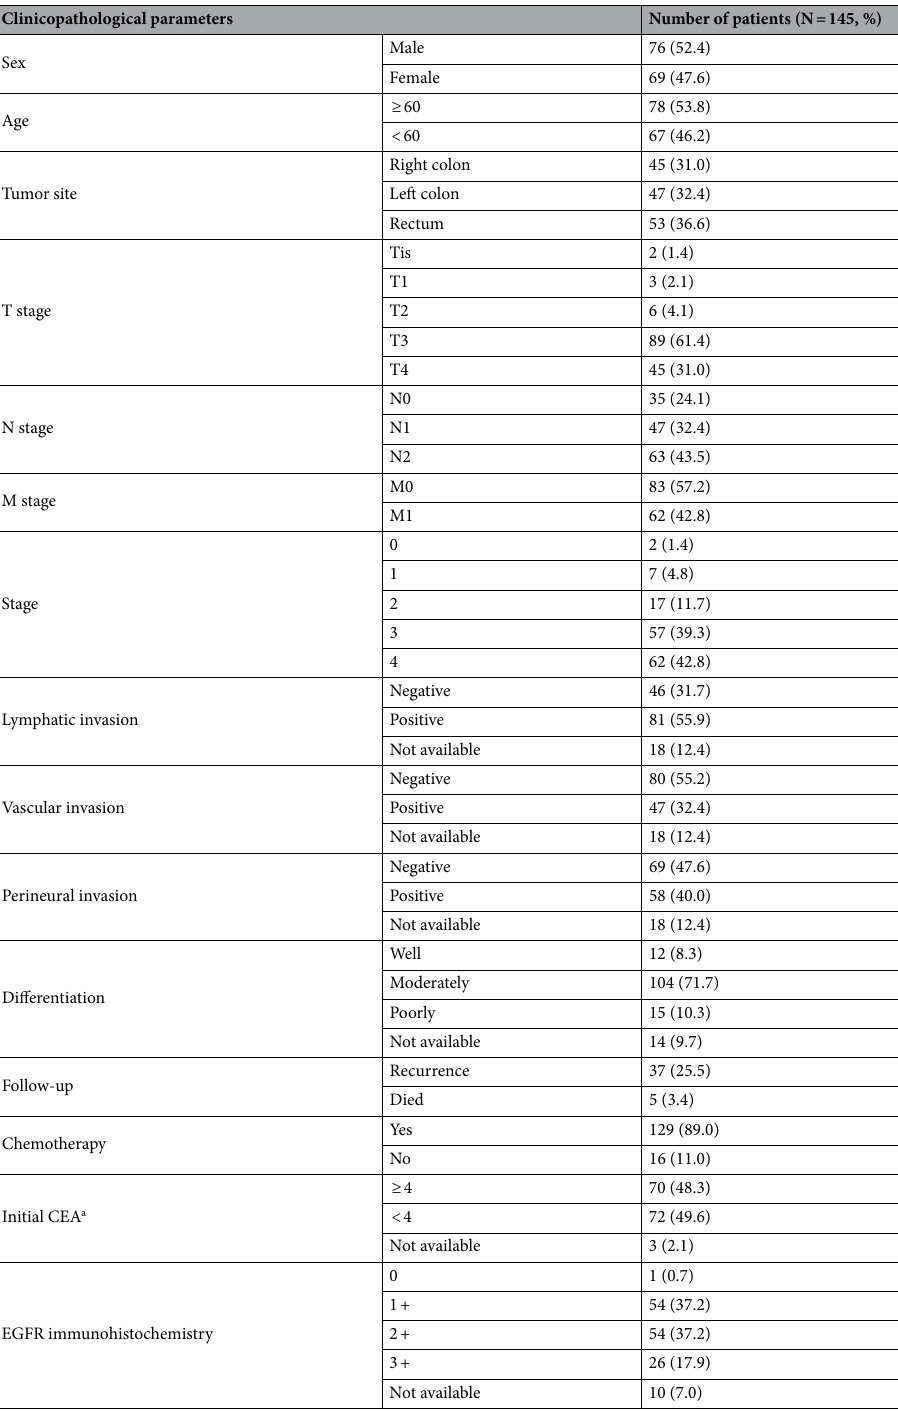
Table 1. Clinicopathological data of 145 colorectal cancer patients. a CEA: carcinoembryonic